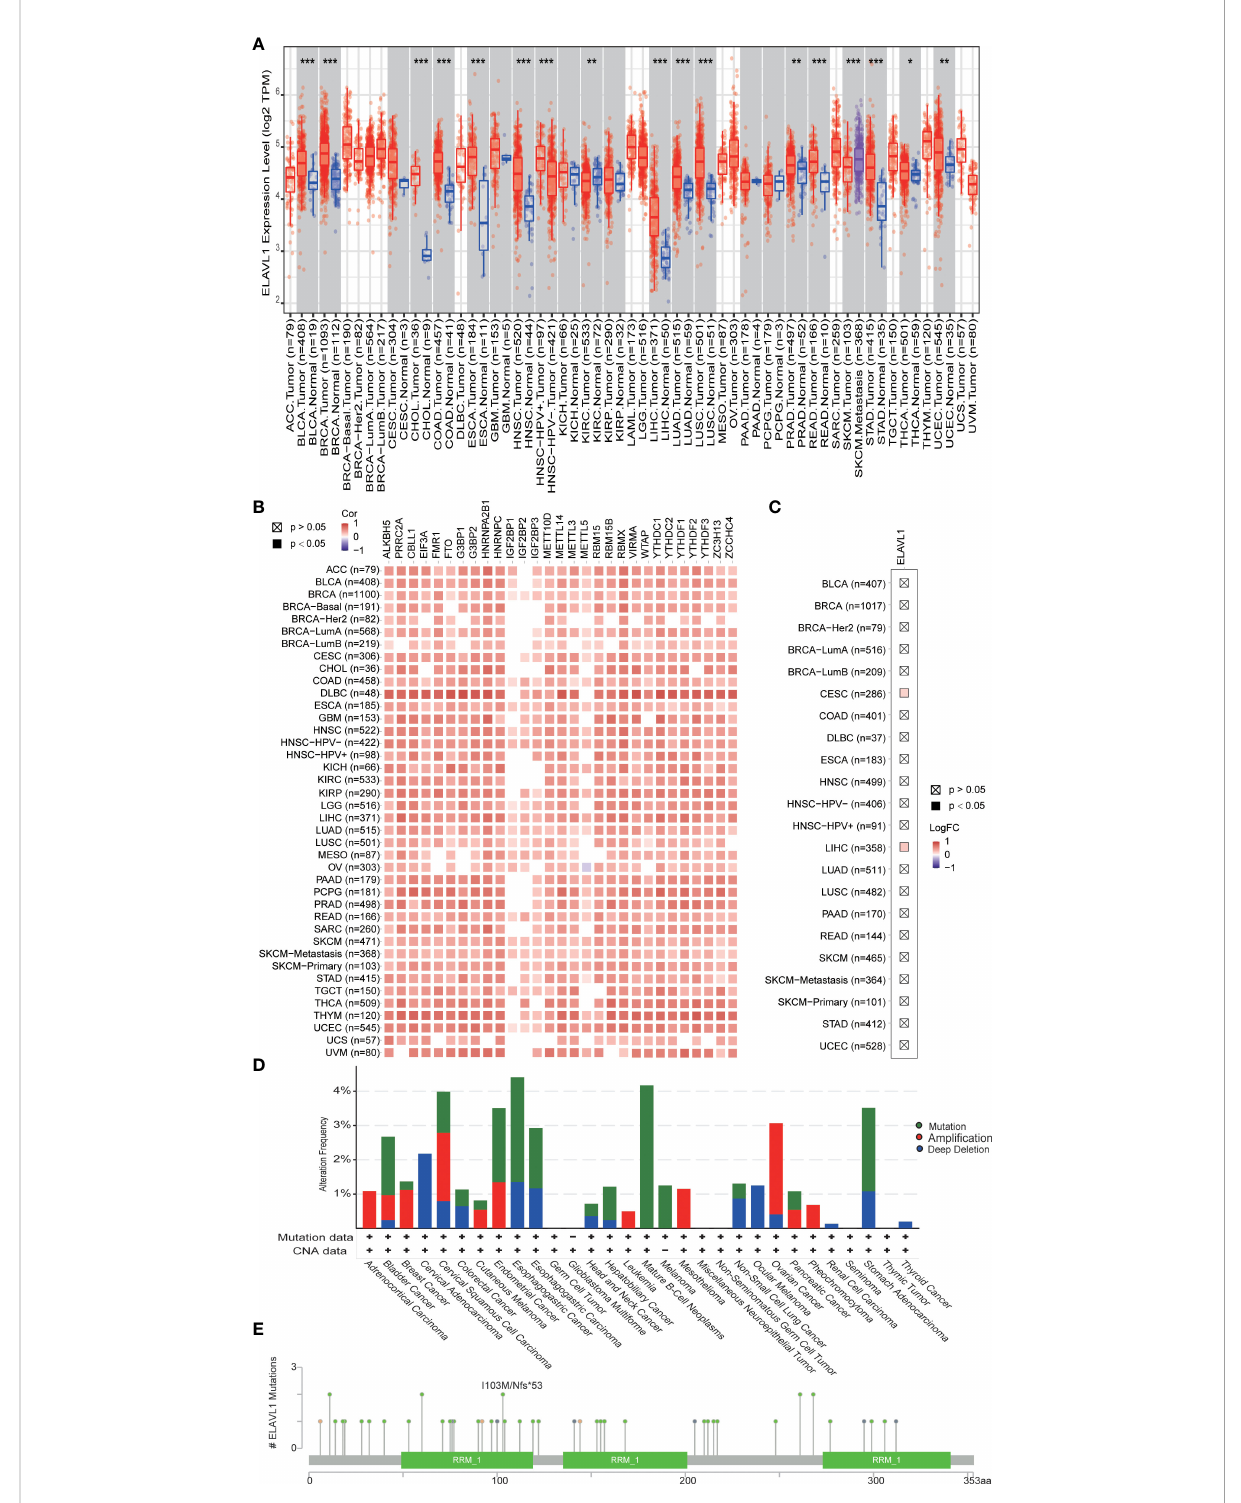
FIGURE 6 ELAVL1 in various types of tumors. (A) ELAVL1 expression in tumors; (B) correlation between ELAVL1 and other m6A regulators in tumors; (C) ELAVL1 mutation in tumors in the TIMER 2.0 database; (D) ELAVL1 mutation and copy number variants in tumors in the CBioPortal database; (E) landscape of ELAVL1 mutation sites. *p < 0.05, **p < 0.01, ***p <